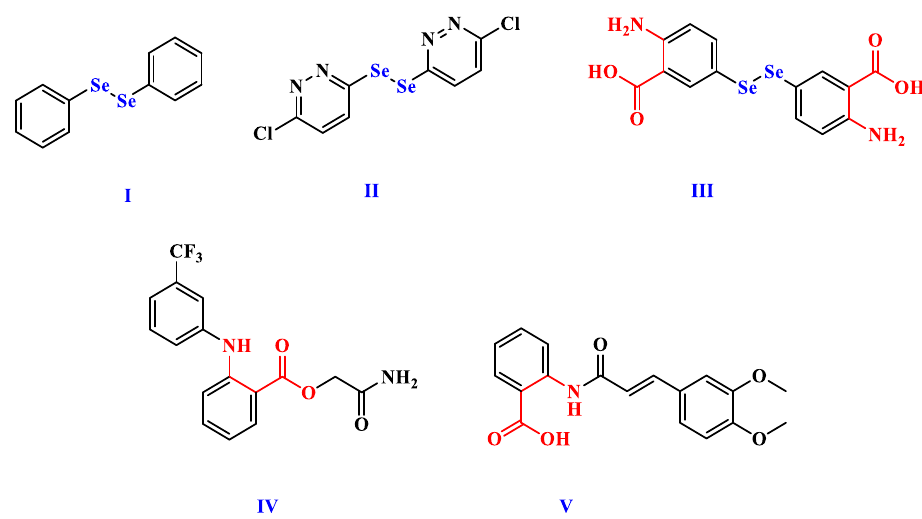
Figure 1. The structure of biologically relevant organoselenium and anthranilic acid analogs. Accordingly, combining the pharmacologically active anthranilate scaffolds and OSe 2 would promote overall biological activities. Therefore, we aim to design and synthe- size new OSe 2- tethered anthranilate hybrids and evaluate their respective antimicrobial, anticancer, and antioxidant properties.